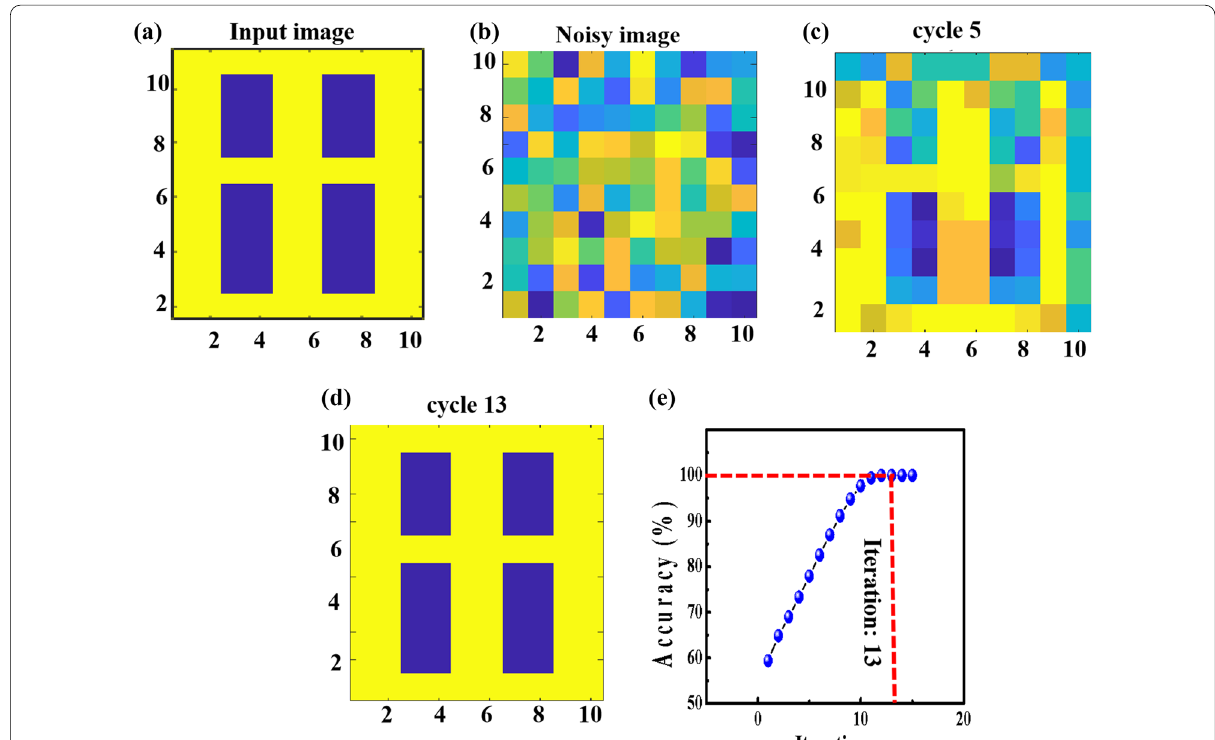
Fig. 5 Pattern recognition simulation. a Input image of 10 10 pixels size for recognition. b Noisy image after weight updating. c Recalled image × after 5 cycles of iteration. d Recalled image after 13 cycles of iteration. e The evolution of accuracy versus number of